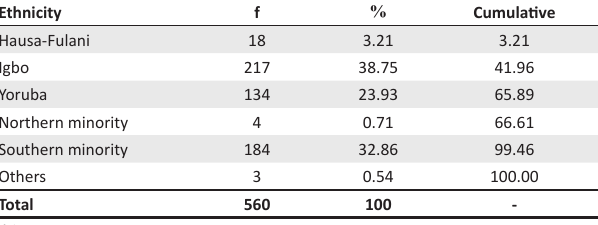
TABLE 1: Ethnic Composition of respondents. Ethnicity f % Cumulative